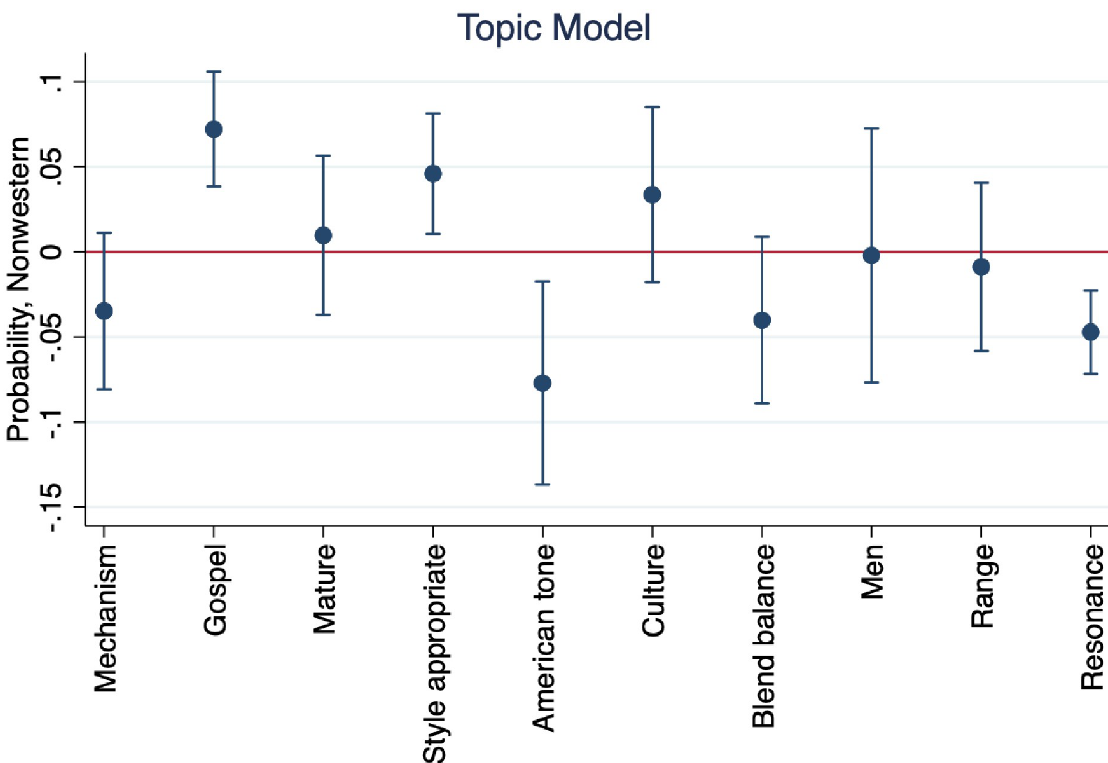
Fig 6. Marginal effects of topics on the probability of non-Western